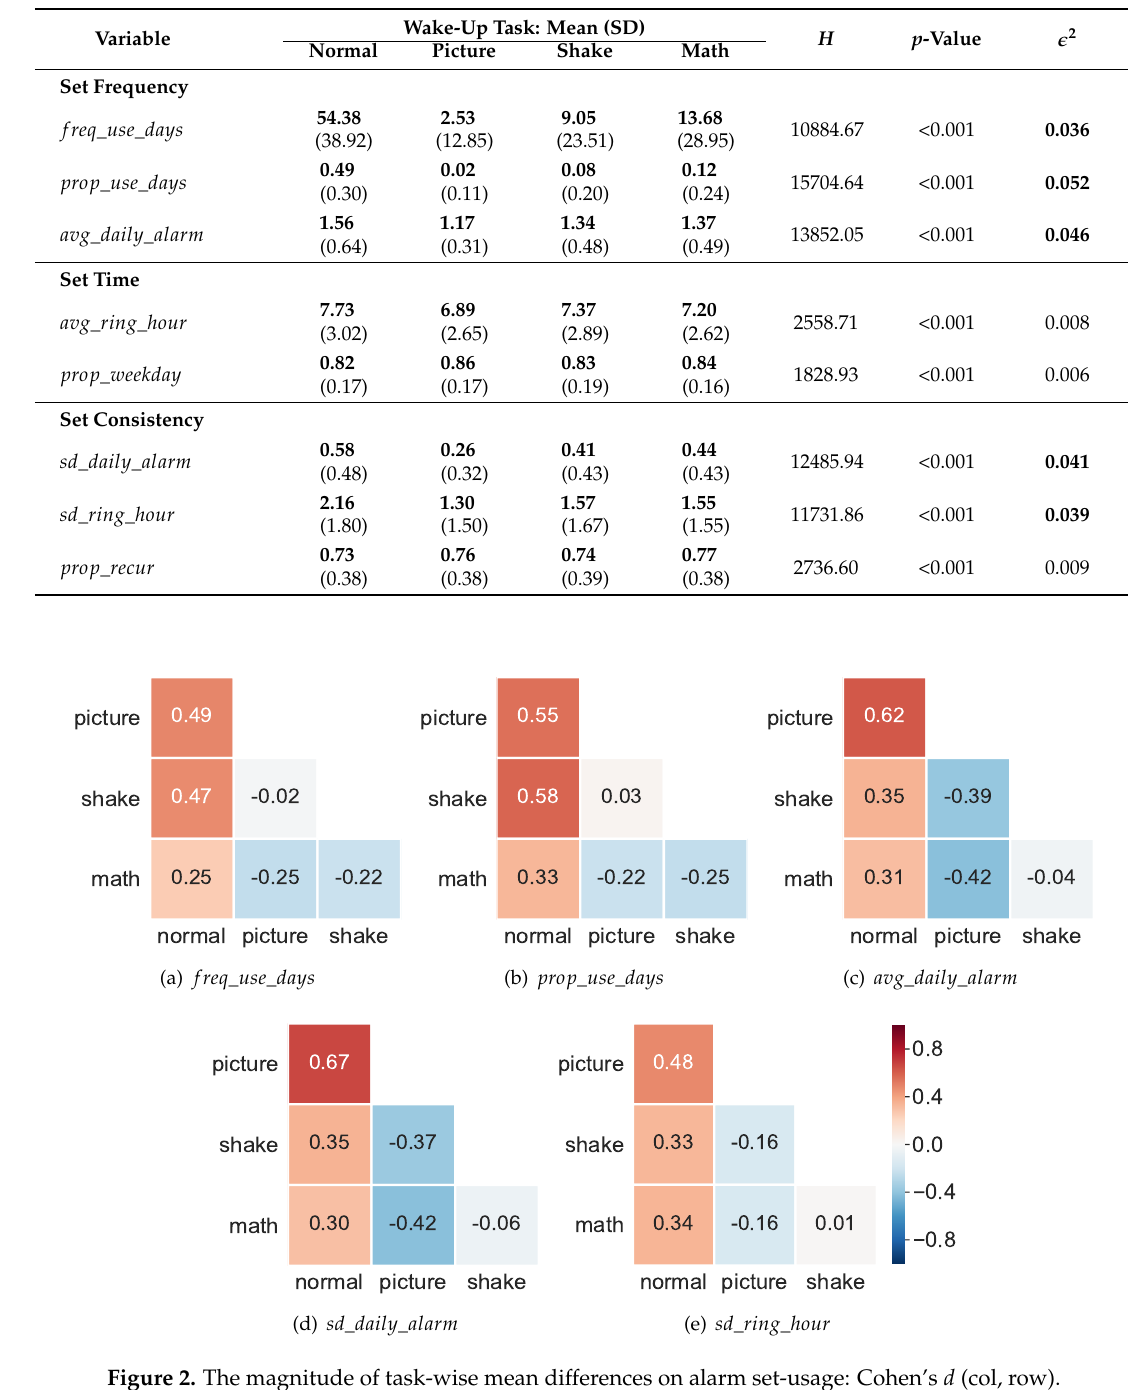
Table 2. Alarm set-usage comparison among the wake-up tasks (Kruskal–Wallis H test).